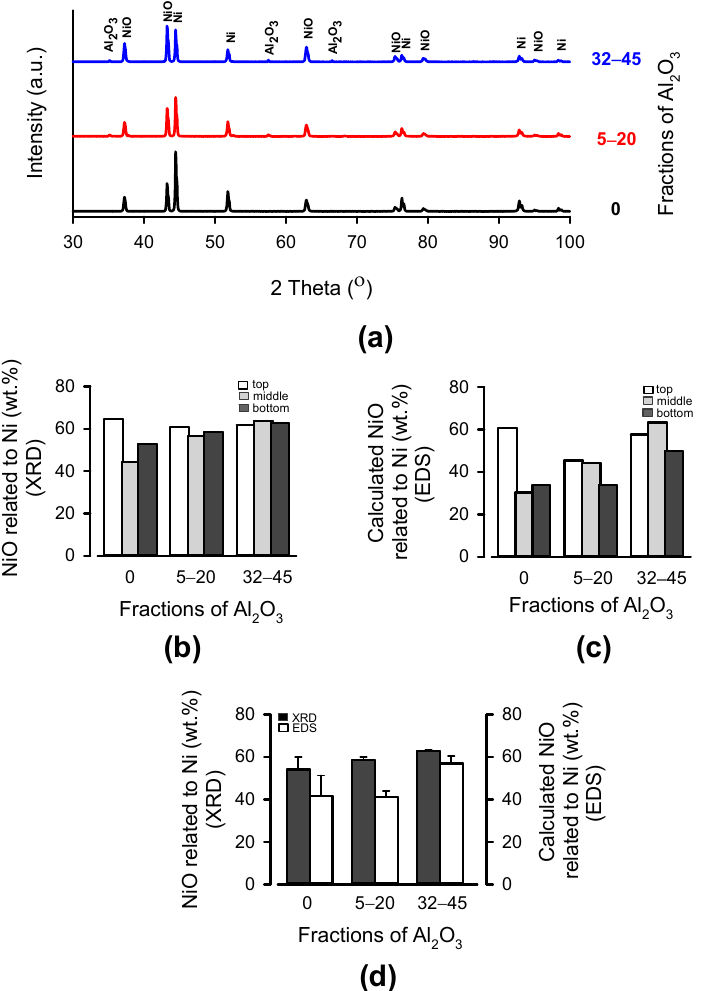
Figure 8. Analysis of NiO after two oxidation cycles. ( a ) X-ray diffraction pattern taken from the middle part of samples; NiO amount derived from ( b ) XRD and ( c ) EDS performed in three different regions (top, middle, and bottom); ( d ) Correlation between averaged XRD and EDS values for NiO. The experimentally determined NiO amount was then related to the sample porosity.